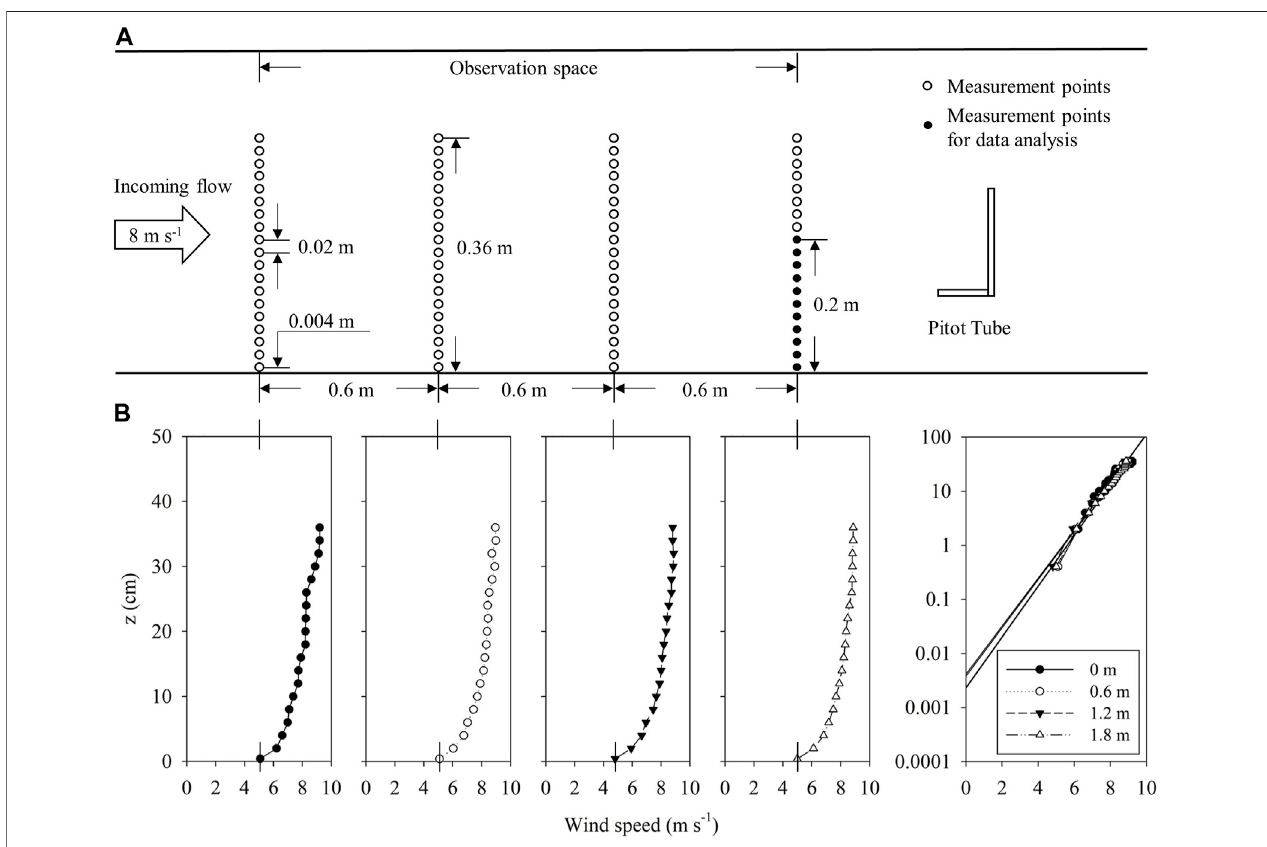
FIGURE 3 | (A) Layout of the measurement point of wind speed in the wind tunnel. (B) Wind speed pro fi les at distances of 0, 0.6, 1.2, and 1.8 m from the start of observation spaceat incoming fl owvelocity of8 m s − 1 . Windspeed measured at theend ofthe observation space between0.4 and 20 cm above thesurface (indicated by solid circles) was used for analyzing aerodynamic characteristics of air fl